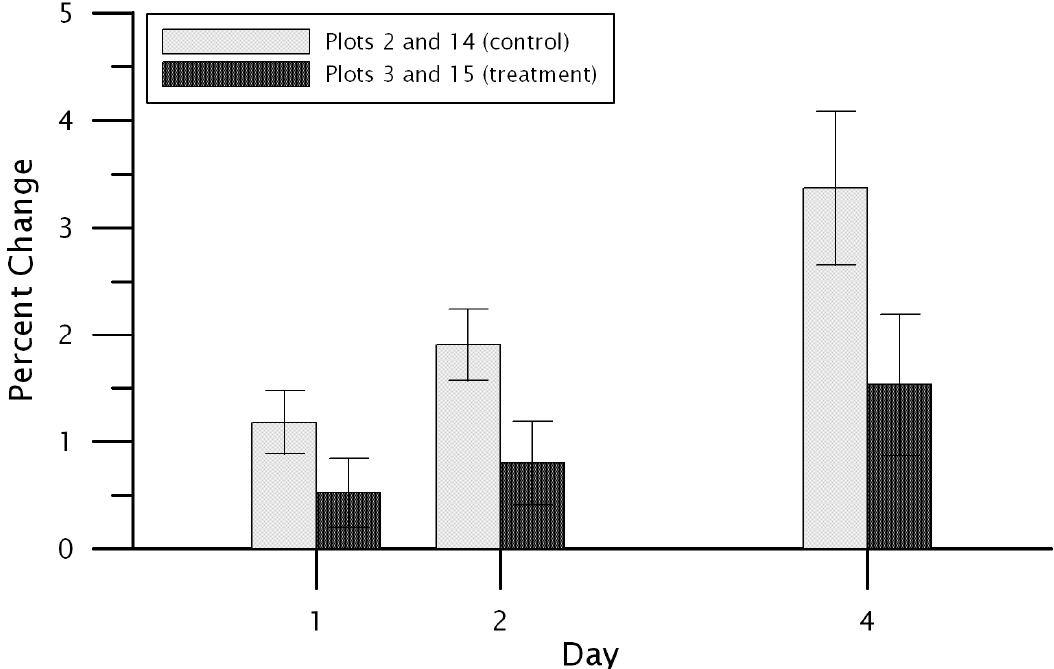
Figure 4. The mean drying rate for the 5 cm depth at the control plots (Plot 2 and Plot 14) and the treatment plots (Plot 3 and Plot 15). The drying rate is shown for 1, 2, and 4 days following precipitation events. Error bars indicate 95 percent confidence limits on the mean.